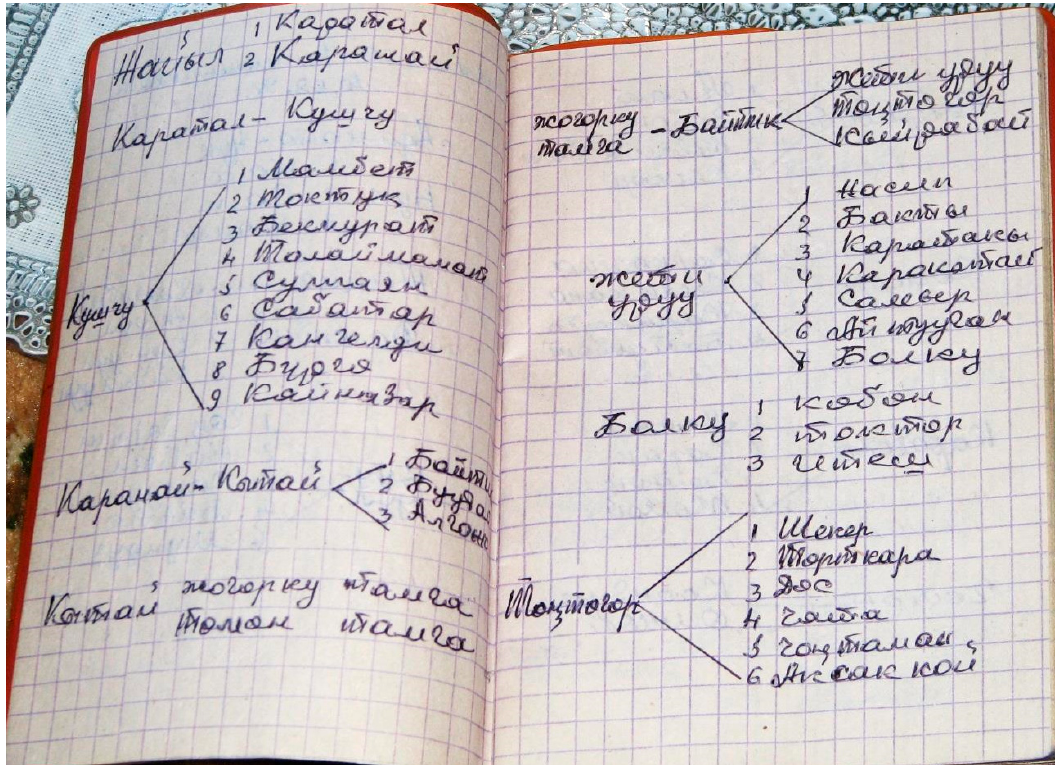
Figure 5. A notebook kept by a veterinarian from a former collective farm, consisting of 25 pages of